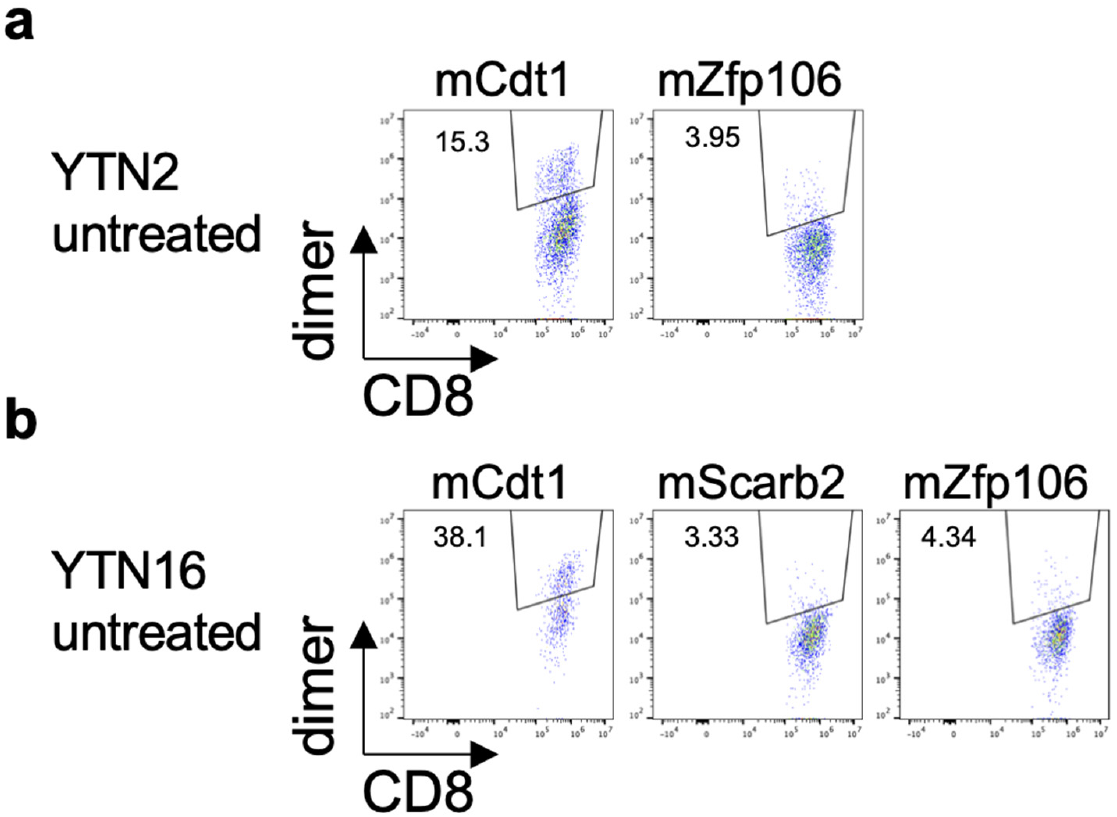
Figure 4. Identification of neoantigen-specific CD8 + T cells in the tumor. Mice ( n = 3) were inoculated with 5 × 10 6 YTN2 or YTN16 cells on day 0. Tumors were harvested on day 17 and tumor-infiltrating cells were analyzed by flow cytometry. Dot plots show frequencies of mCdt1- and mZfp106-reactive CD8 + T cells in YTN2 ( a ) and mCdt1, mScarb2 and mZfp106-reactive CD8 + T cells in YTN16 ( b ).